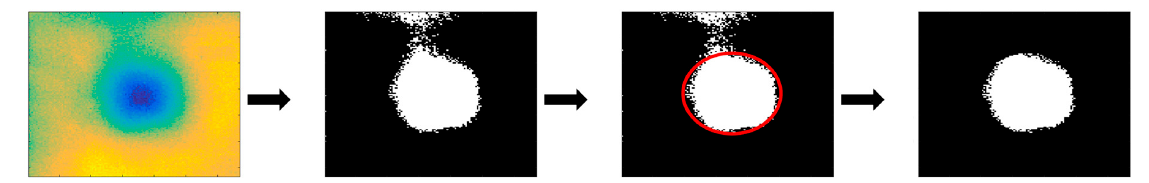
Figure 2. Damaged area identification procedure with the Temperature Difference Method.